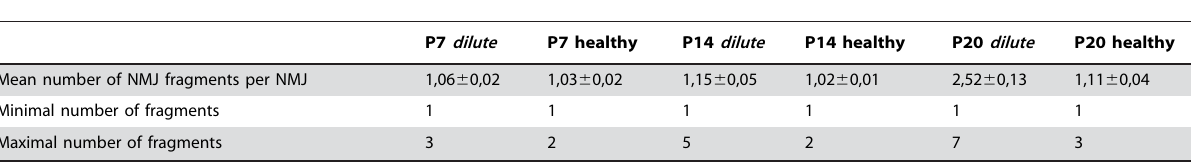
Table 1. NMJ fragmentation in DLS/LeJ mice.